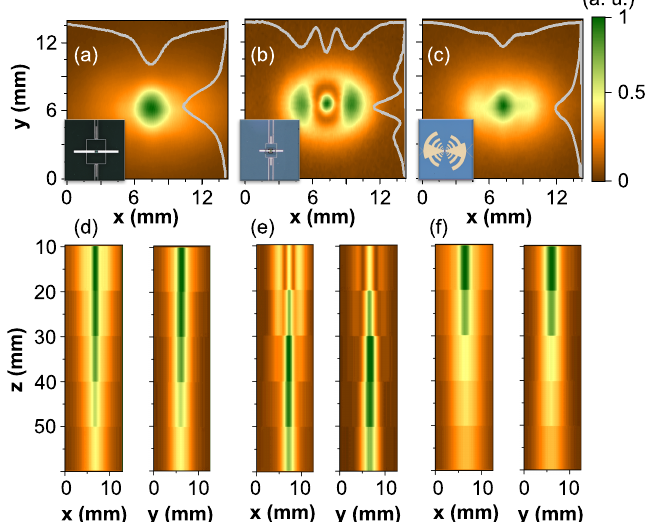
Figure 3. The radiation patterns measured with different Ti- µ bolometers placed at z = 10 mm position: Panel ( a )—0.3 THz µ bolometer; panel ( b )—0.7 THz Ti- µ bolometer, panel ( c )—wideband Ti- µ bolometer. Grey lines indicate intensity center cross-sections along the relevant axes. Note particular spatial mode profiles clearly resolved by different antenna-coupled Ti- µ bolometers. Panels ( d – f ) depict x − z and y − z scans from 10 mm to 50 mm along z direction for 0.3 THz, 0.7 THz and wideband Ti- µ bolometers,